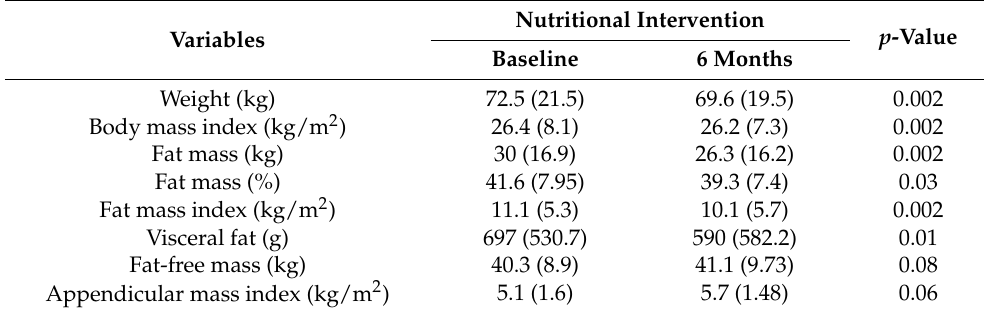
Table 1. Anthropometric and body composition characteristics of 16 women diagnosed with breast cancer at baseline and after 6 months food-based nutritional intervention during active antineoplastic treatment 1